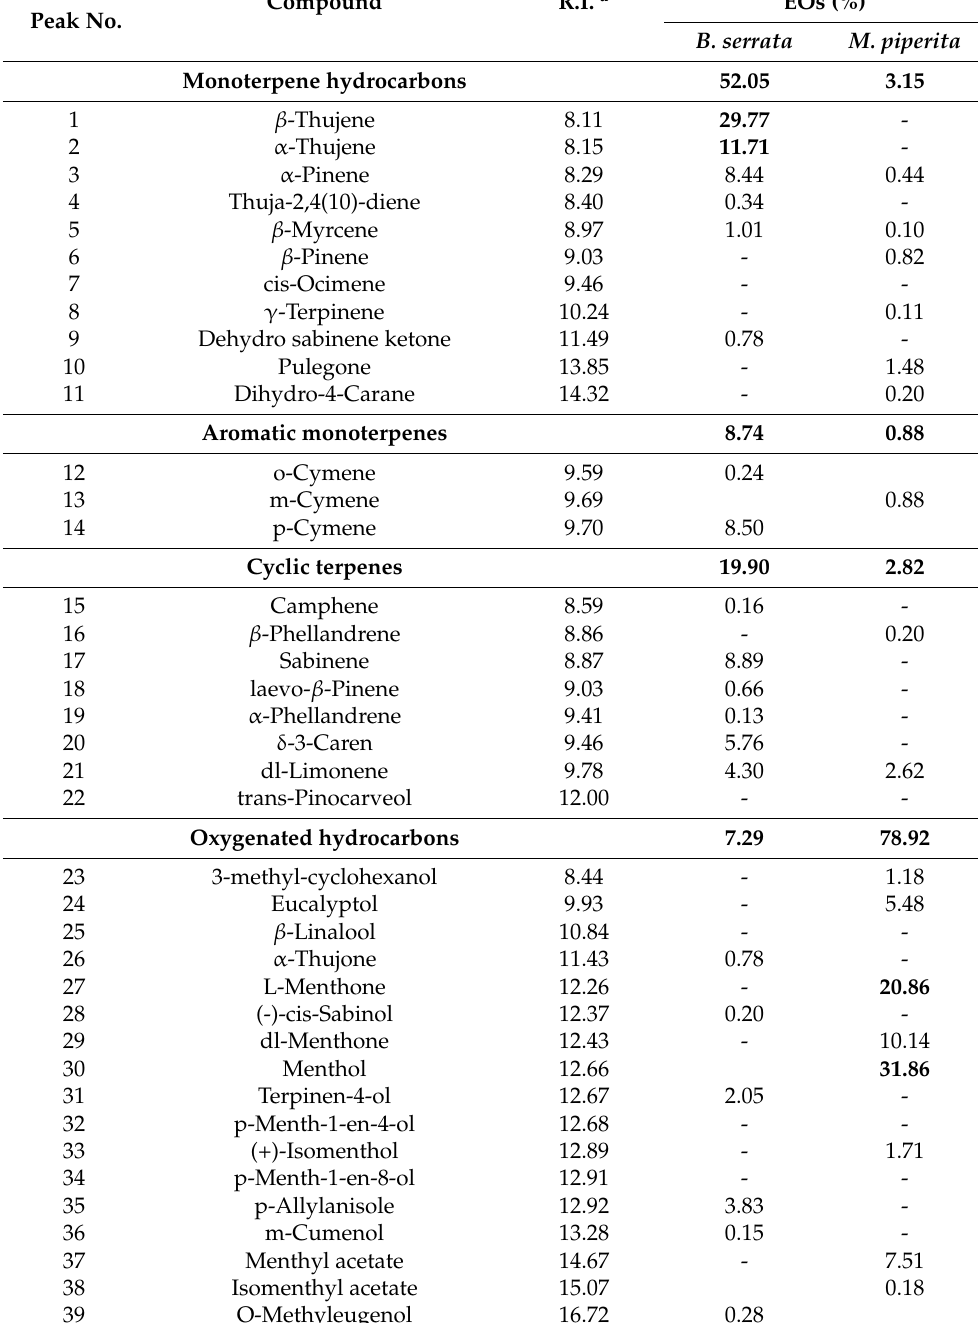
Table 2. Chemical composition of EOa of B. serrata and M. piperita . Peak